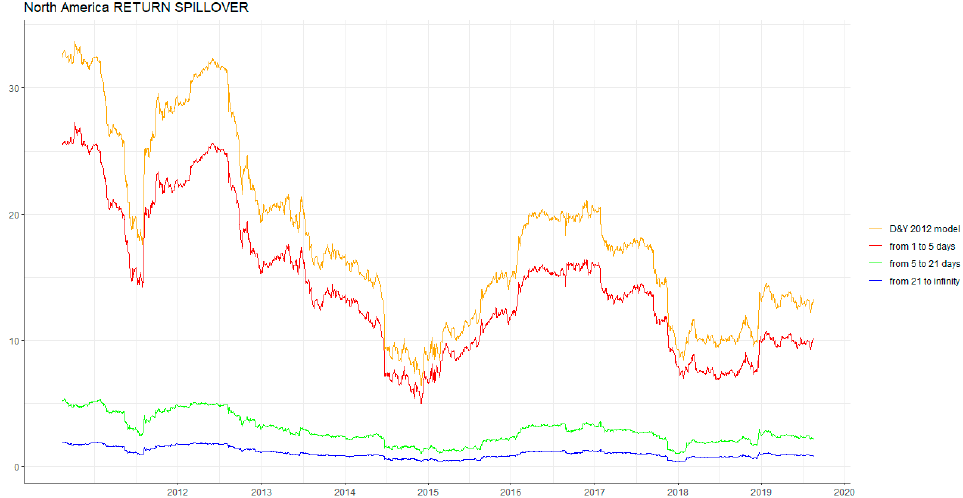
Energies 2020 , 13 , x FOR PEER REVIEW Figure A5. Total return spillover of DY12 and BK18 in North America (Windows 250).